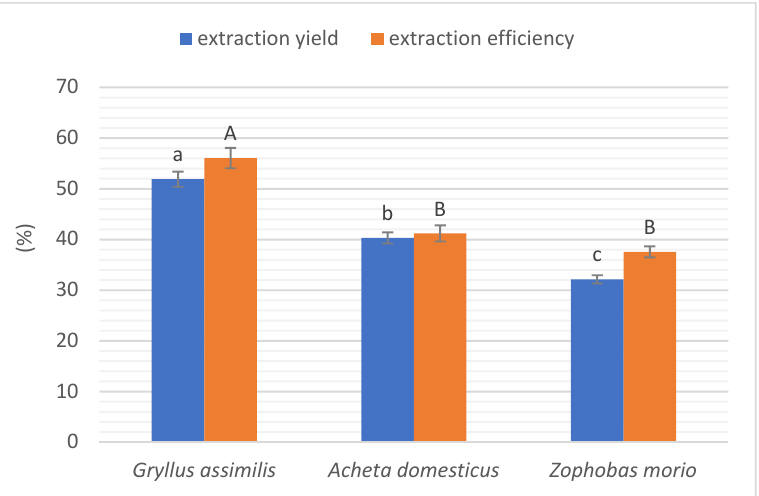
Figure 1. Extraction yield and efficiency of protein. Different letters indicate a significant difference ( p < 0.05) for extraction yield. Different capital letters indicate a significant difference ( p < 0.05) for extraction efficiency.